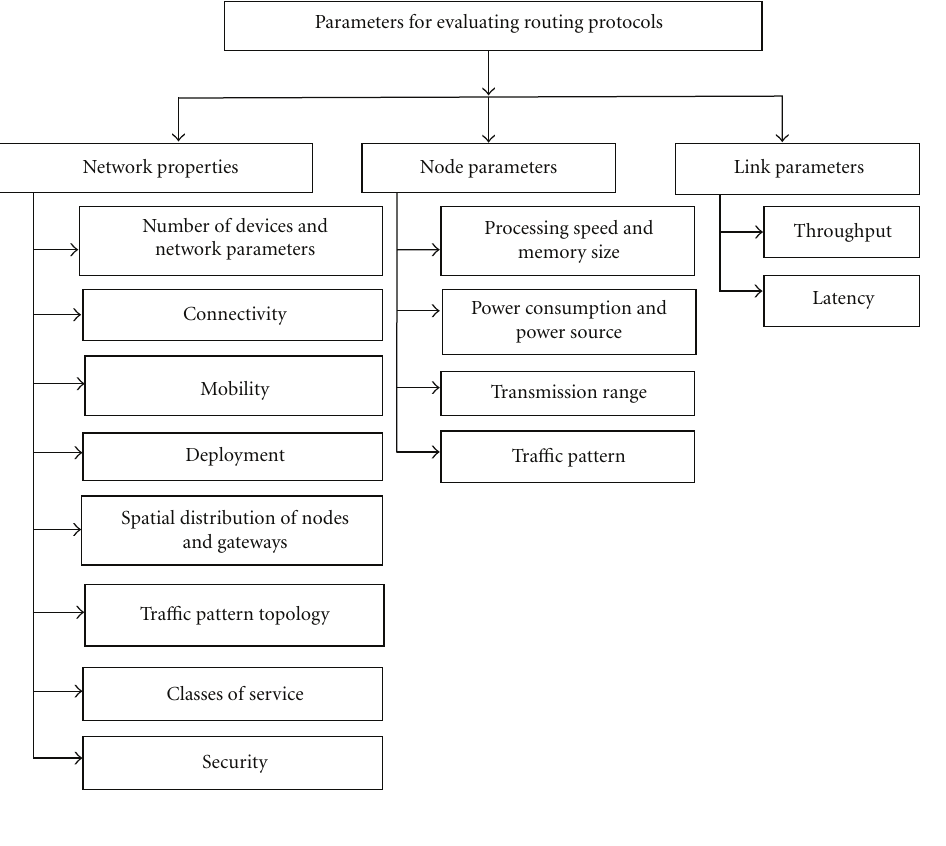
Figure 3: Taxonomy of parameters for evaluating routing.